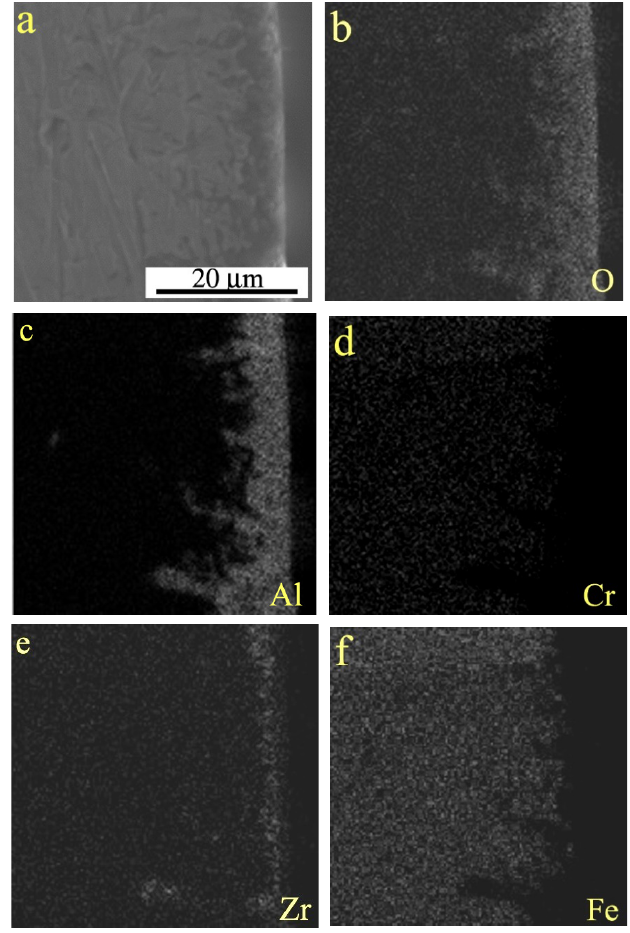
Figure 6. SEM image and elemental mappings of cross-sectional microstructure of sample oxidized at 1260 ◦ C for 3 h: ( a ) SEM image, ( b ) O, ( c ) Al, ( d ) Cr, ( e ) Zr, ( f )